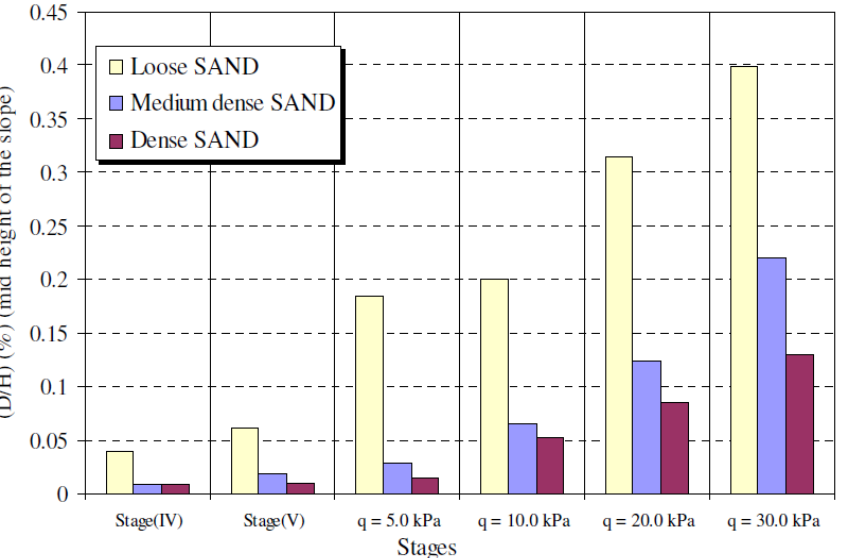
Figure 5. Influence of soil density on the horizontal movement at mid-height of slope.